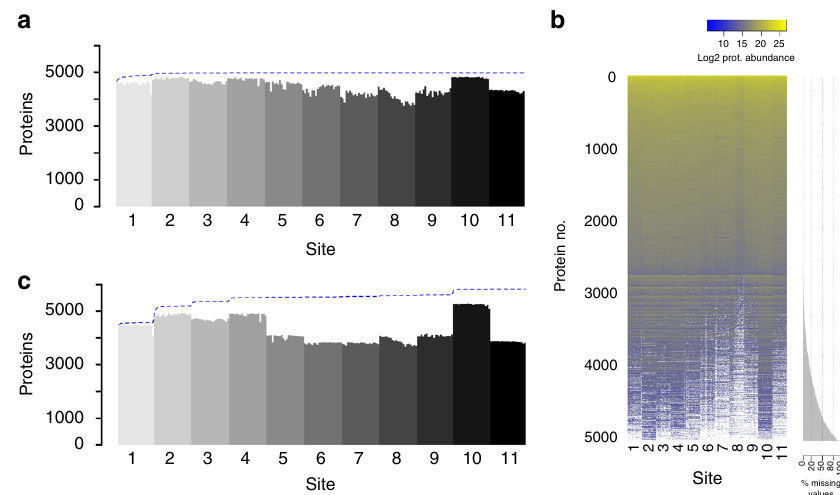
Fig. 2 A consistent set of proteins is detected across sites. a The number of proteins detected in each of the 229 SWATH-MS analyses is shown ordered by site of data collection and then chronologically by time of acquisition. After fi ltering the data set in a global fashion at 1% FDR at the peptide query and protein levels, a protein was considered detected in a given sample when a peak group for that protein was detected at 1% FDR in the context of that sample (see Supplementary Note 2 for a detailed discussion of FDR). The blue line indicates the cumulate set of proteins detected with each new sample moving from left to right. The maximum of the blue line indicates the set of proteins detected at 1% FDR in the global context. The saturation of the number of proteins detected after a few samples indicates that the set of proteins observed by all sites is highly uniform. b A protein abundance matrix on the log2 scale is shown for 229 SWATH-MS analyses from all sites corresponding to the set of proteins shown in a . White indicates a missing protein abundance value where a given protein was not con fi dently detected in a given sample. The proteins are ordered from top to bottom fi rst by row completeness and then by protein abundance. c Equivalent to a except that the analysis and FDR control is carried independently out on a site-by-site basis instead of aggregated across all sites before analysis and FDR